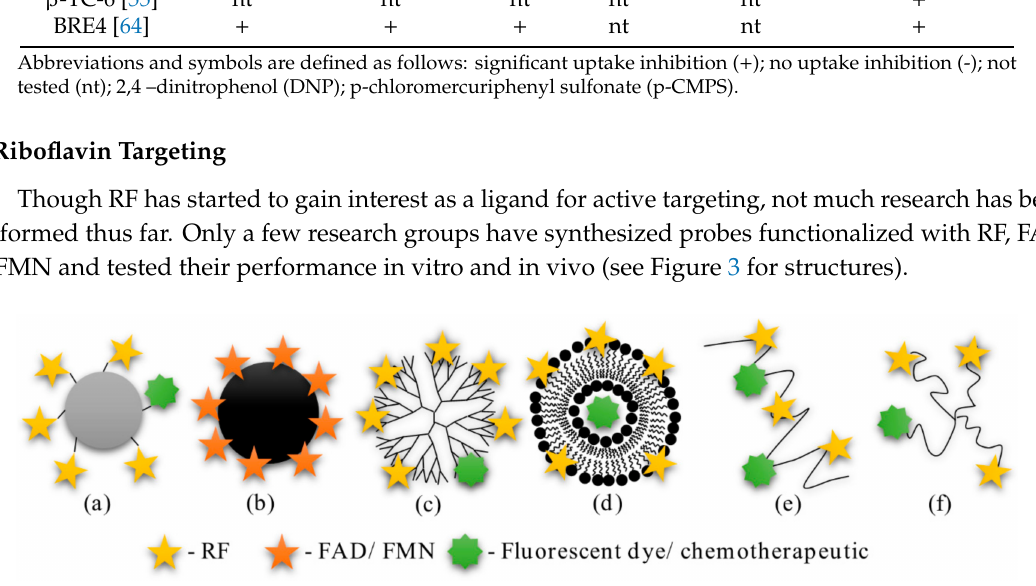
Figure 3. Probes designed to actively target RFVTs: ( a ) Bovine serum albumin-RF